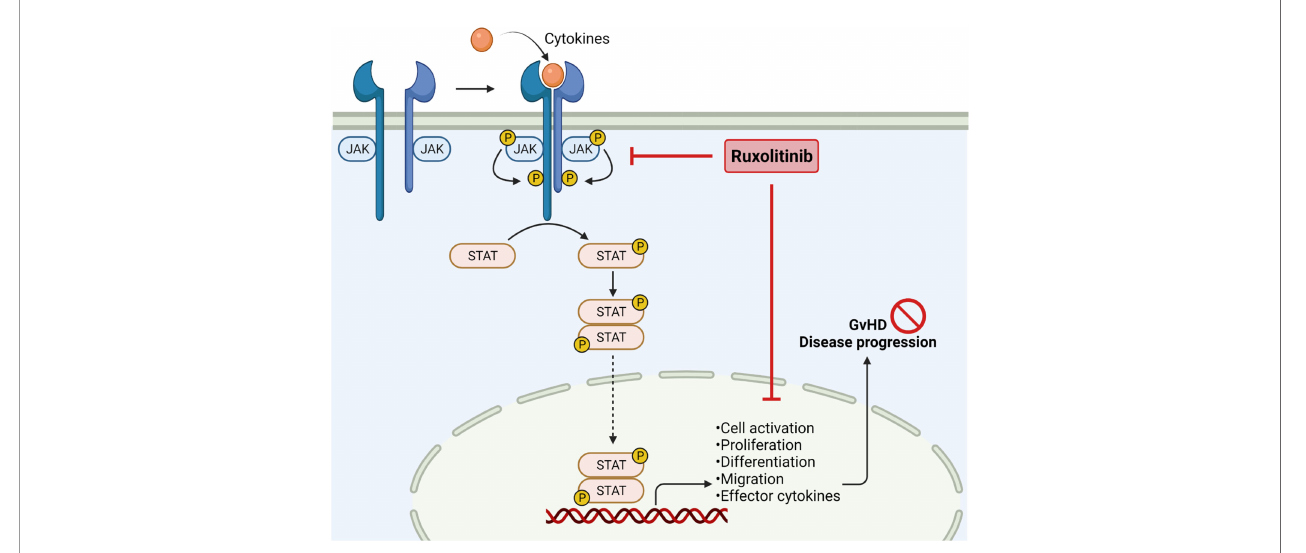
FIGURE 1 | JAK2 inhibition in Graft- versus -Host Disease. Janus kinases are crucial to mediate extracellular signals. Binding of cytokines results in receptor dimerization and phosphorylation, subsequently phosphorylating STAT molecules by receptor tyrosine kinases. Phosphorylation of STAT leads to dimerization and translocation into the nucleus, followed by enhancing gene transcription. JAK/STAT signaling is important in regulating cell activation, proliferation, migration and effector cytokine production, thereby enhancing GvHD severity. JAK1/2 inhibition by ruxolitinib reduces pro-in fl ammatory signaling and cell migration, resulting in reduced GvHD disease progression. Created with